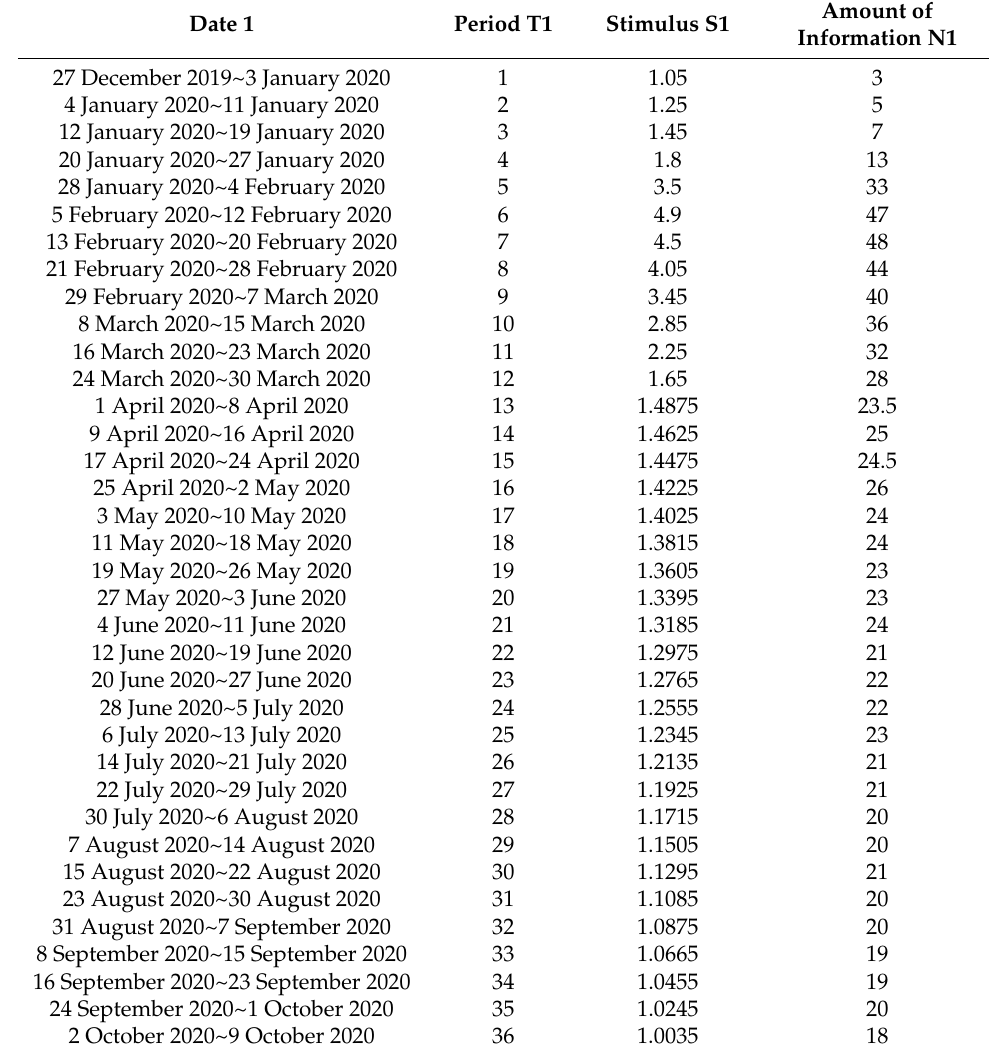
Table 11. Assignment of S and N to Long Period